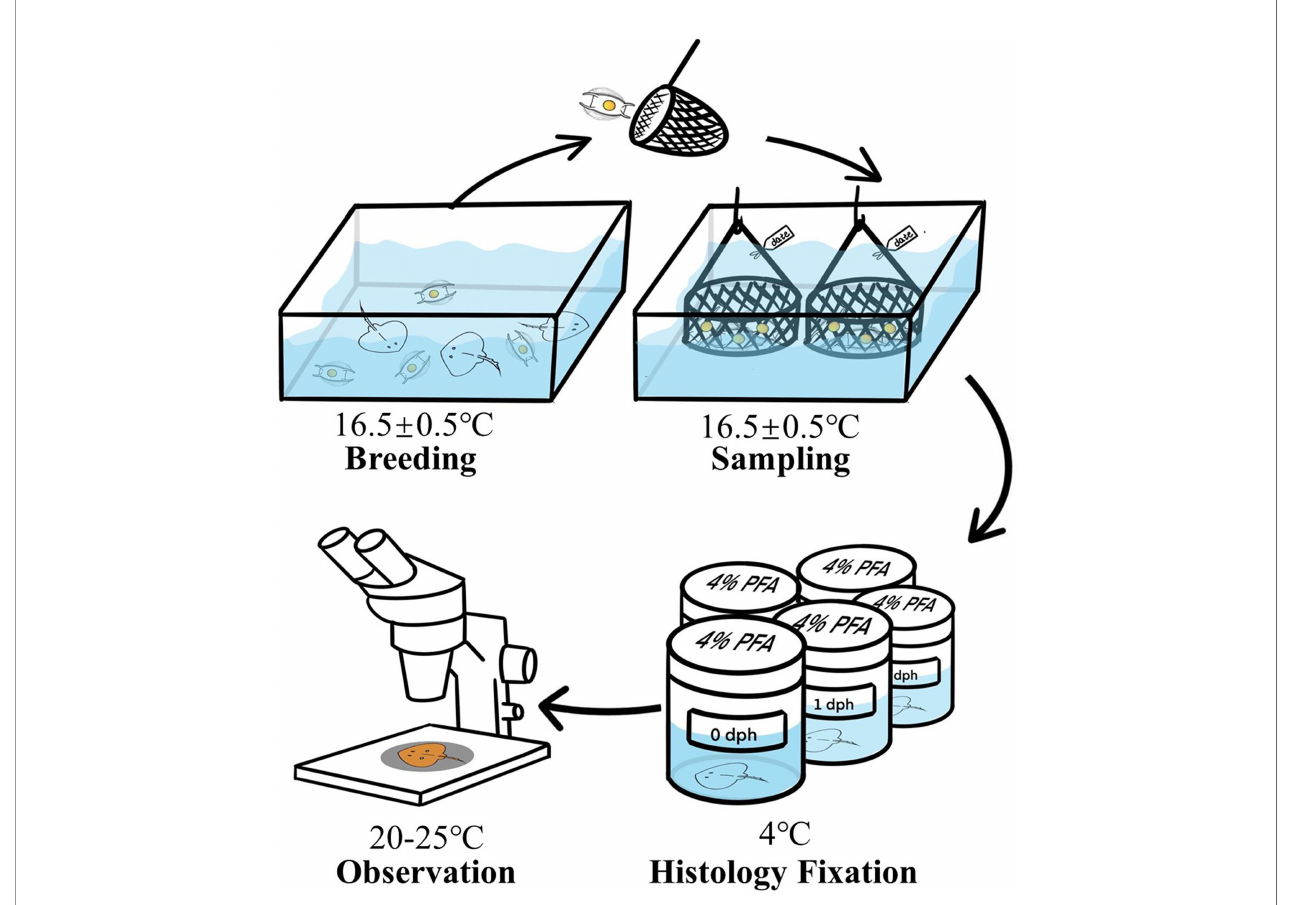
FIGURE 1 | Schematic diagram of the experimental